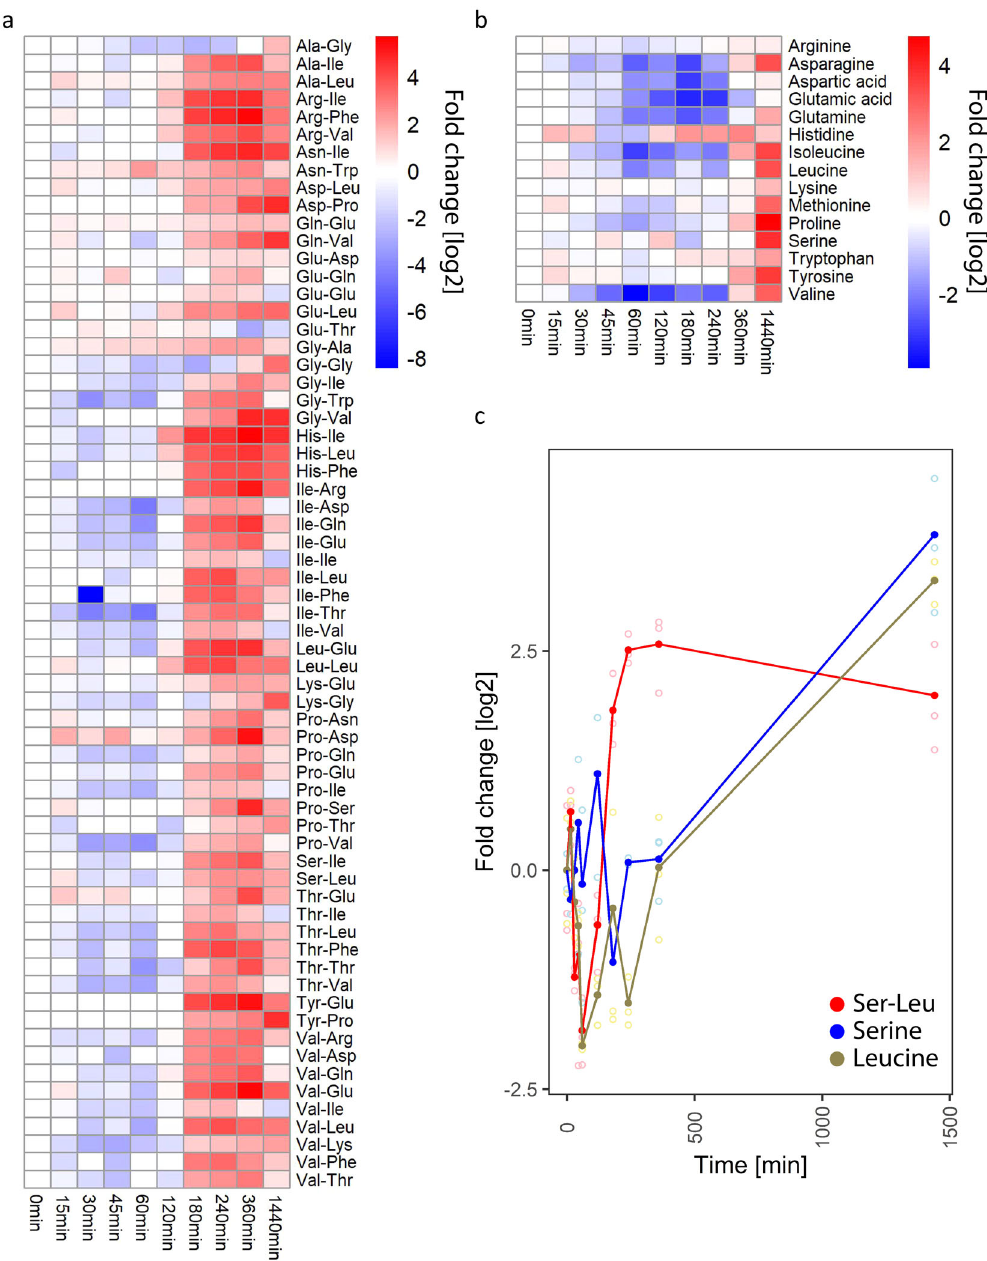
Fig. 6 Analysis of dipeptide and amino acids fl uctuations in yeast under control growth conditions (30 °C). a Heatmap showing fl uctuation of dipeptides level in yeast (Supplementary Data S30). b Heatmap showing fl uctuation of amino acids level in yeast (Supplementary Data S30). c Plot showing fl uctuation of Ser-Leu, serine and leucine level in yeast. Shown are relative changes to time point 0. Data represent the means n = 3 independent samples. Ratios were log transformed (log base